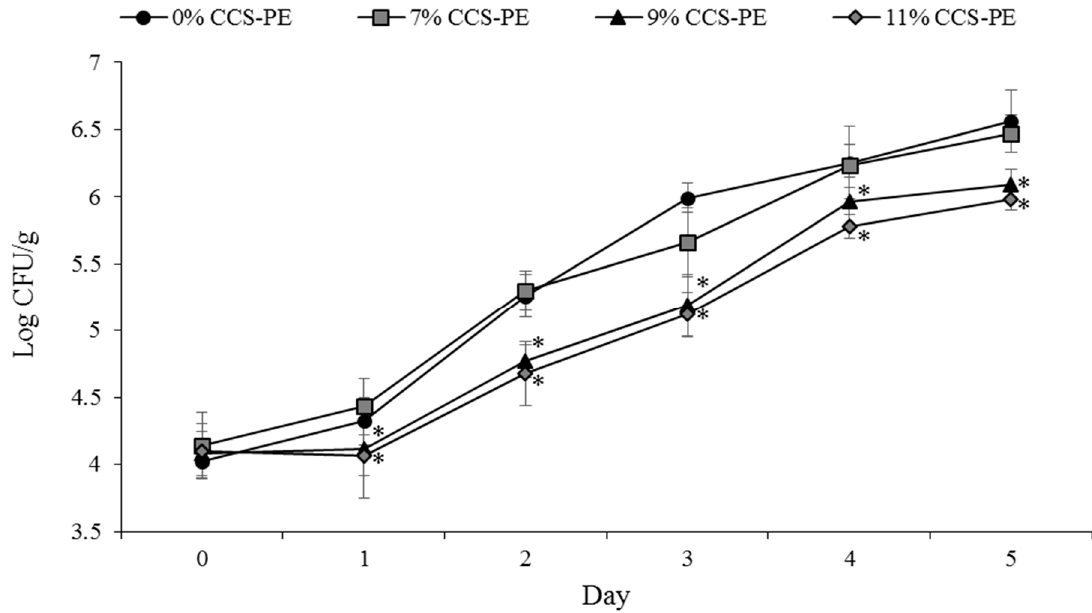
Figure 4. Effect of 0%, 7%, 9%, and 11% CCS-PE plastic bags on the total aerobic viable counts (TVC) of raw fish fillet. Results are reported as mean ± SD ( n = 5) colony forming units (CFU) (Log 10 /g). * p < 0.05 when compared with 0% CCS-PE plastic bag group.